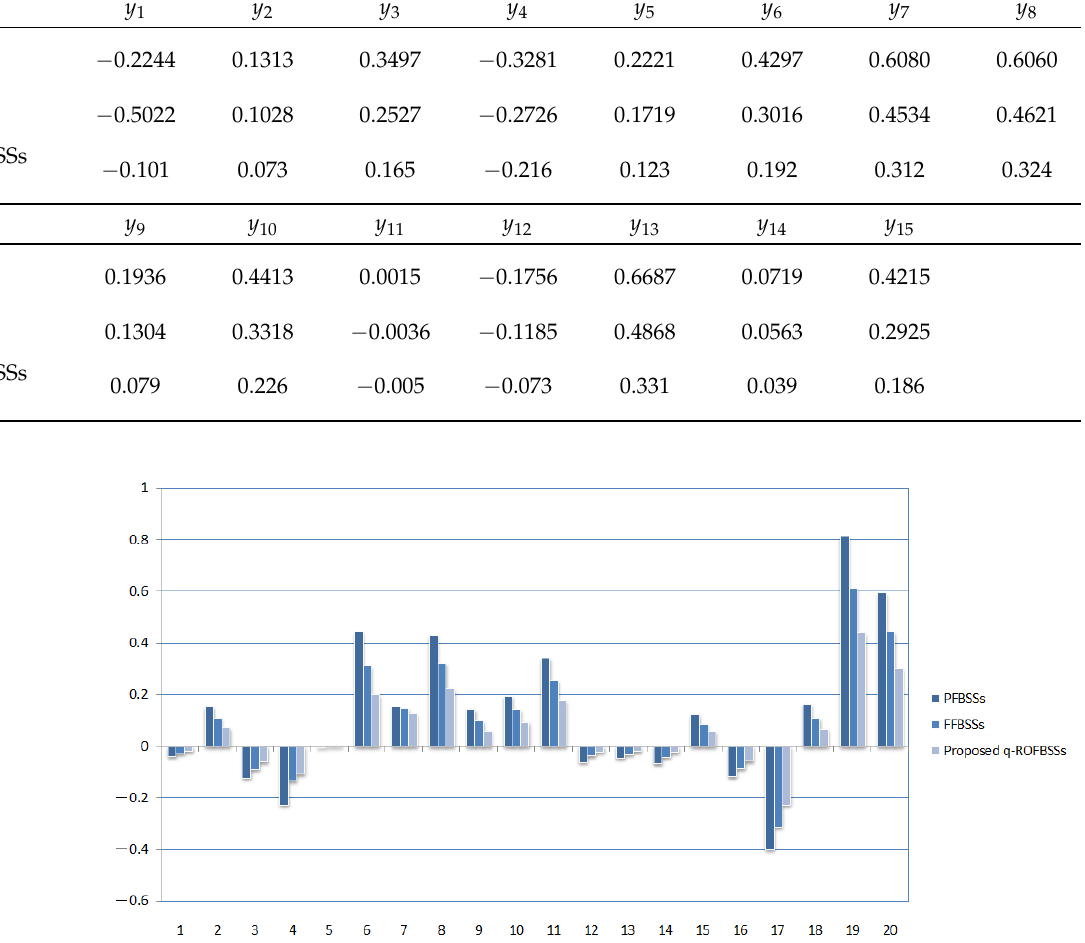
Figure 2. Comparison between PFBSSs [28], FFBSSs [30], and proposed q -ROFBSSs by applying on Application 1 (Selection of an employee) in